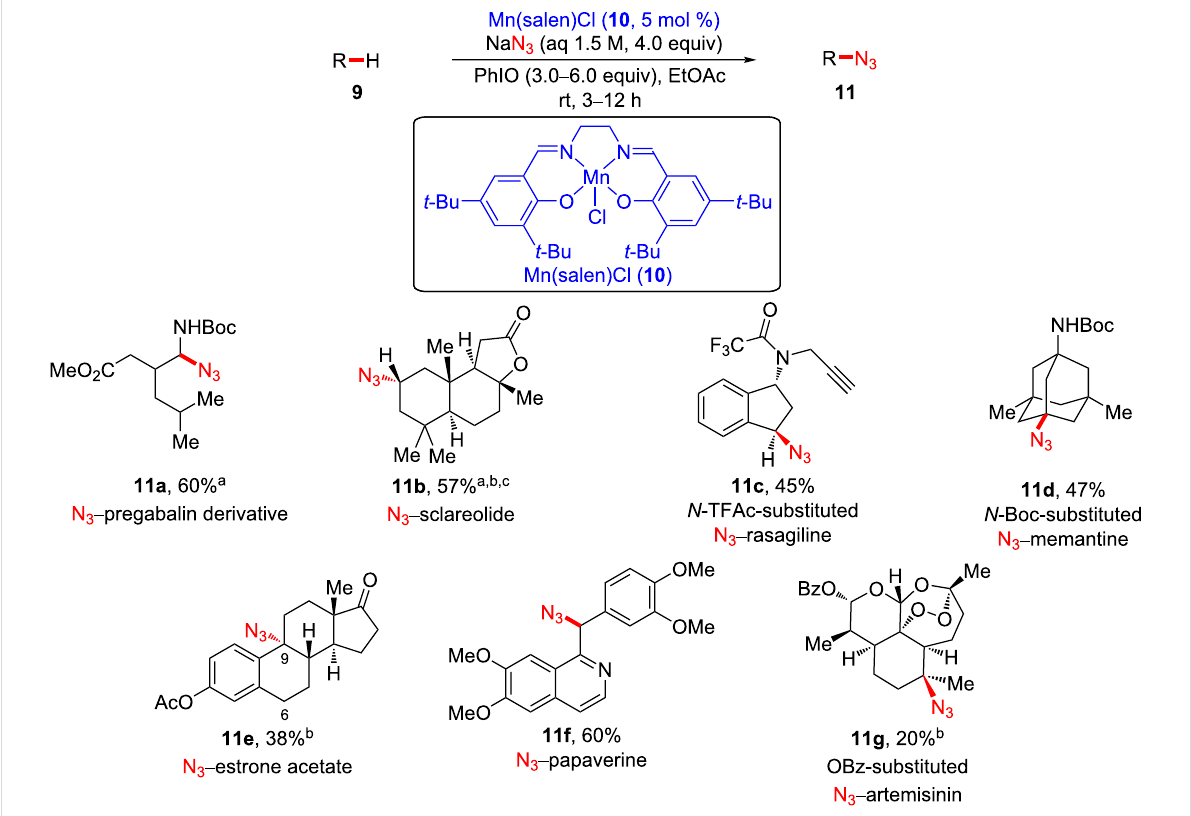
oxidized to Mn(III)/L–N 3 . Azide radical addition to Mn(II)/L to form Mn(III)/L–N 3 was considered as a possible route.